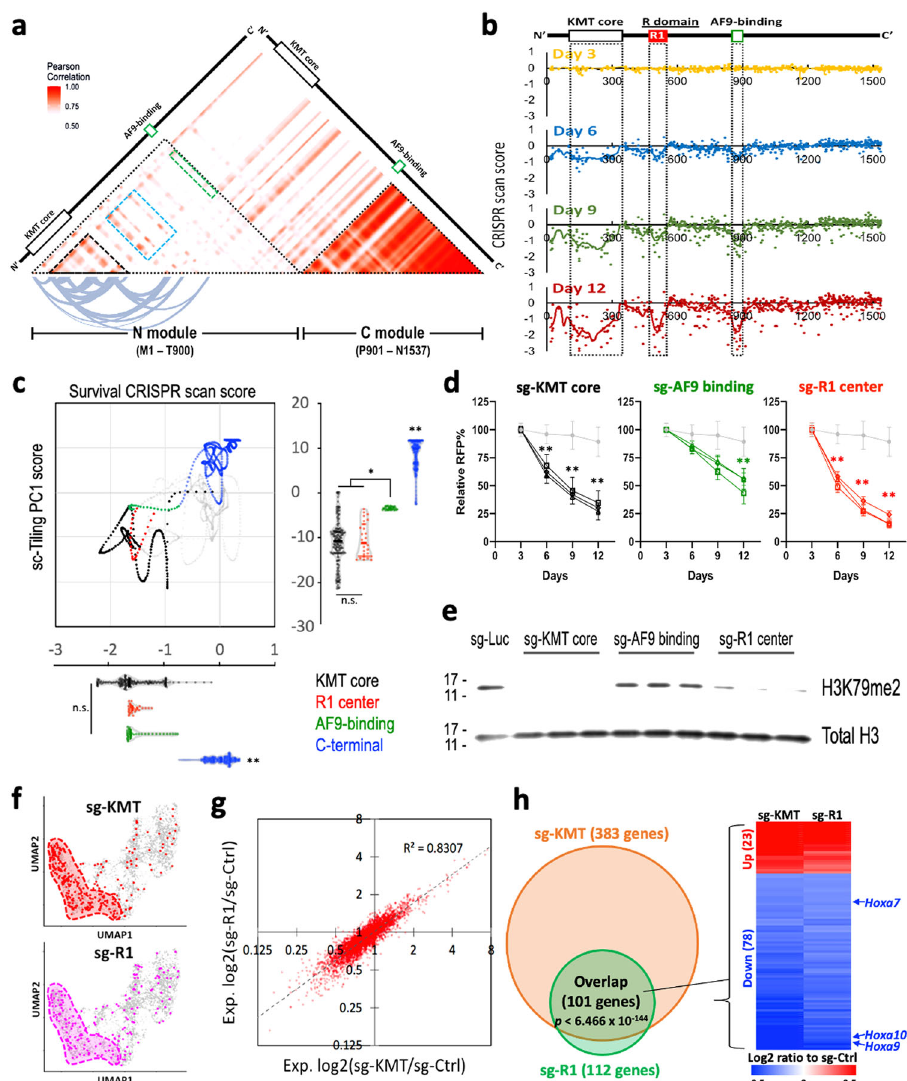
Fig. 2 sc-Tiling pinpoints functional elements in DOT1L. a Heatmap depicts Pearson correlations between sgRNAs targeting different positions across the DOTL1 protein. The curved lines indicate highly correlative (Pearson score >0.8) residue pairs in the N-module of DOT1L. b CRISPR scan score of each sgRNA (dots) and smoothed score (line) of the DOT1L-tiling survival screen in MLL-AF9-Cas9 + leukemia at the indicated number of days in culture. c Combinational analysis of the sc-Tiling principal component 1 (PC1; y -axis) and survival CRISPR scan score (day 12; x -axis) of individual amino acid residues (dots) in DOT1L. Residues compose of R1 center (E489 – L515; red dots) correlate with the KMT core (black dots) at both the transcriptomic and cellular survival phenotypes. * P < 0.01 by two-sided Student ’ s t test. ** P < 0.01 to all other groups. d Effect of individual sgRNAs targeting the KMT core (black; three independent sgRNAs), AF9-binding motif (green; three independent sgRNAs), or R1 center (red; three independent sgRNAs) of DOT1L on the proliferation of MLL-AF9-Cas9 + leukemia. Data represent mean ± 95% con fi dence interval of a quadruplicate experiment. ** P < 0.001 by two-sided Student ’ s t test compared to a sgRNA targeting Luciferase (sg-Luc; gray). e Western blot of H3K79me2 and total histone H3 in MLL-AF9-Cas9 + cells expressing indicated sgRNAs (three independent sgRNAs per domain). f Annotation of cells harboring sgRNAs targeting the KMT core (red) or R1 element (pink) on UMAP. g Correlation of gene expression changes induced by sgRNAs targeting the KMT core ( x -axis) and R1 element ( y -axis) summarized